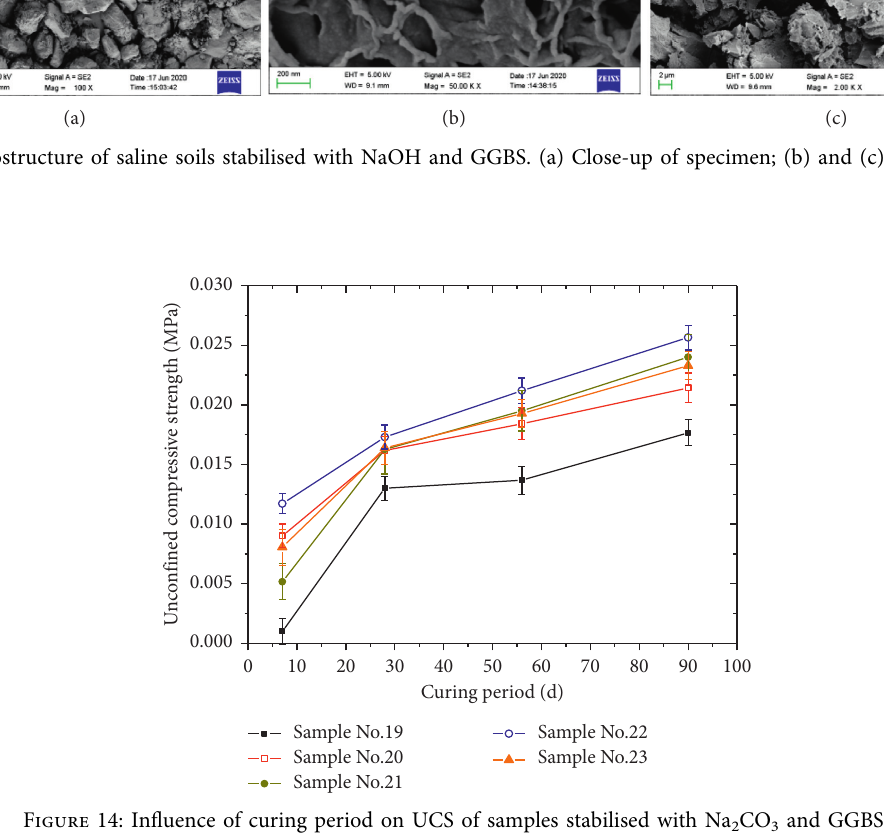
2 CO 3 and GGBS.